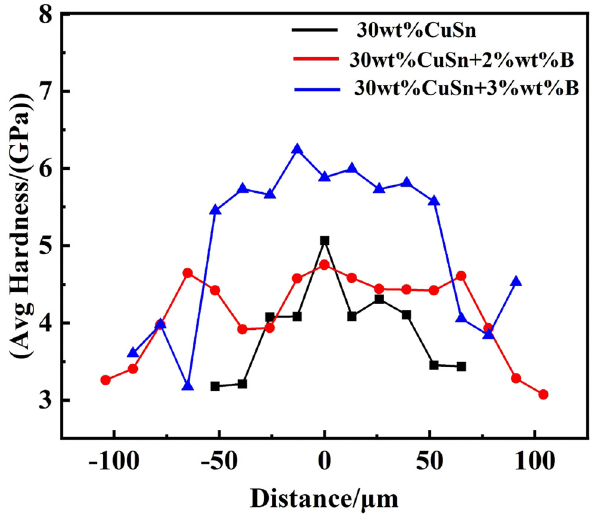
Figure 12: Average hardness of the brazing seam.